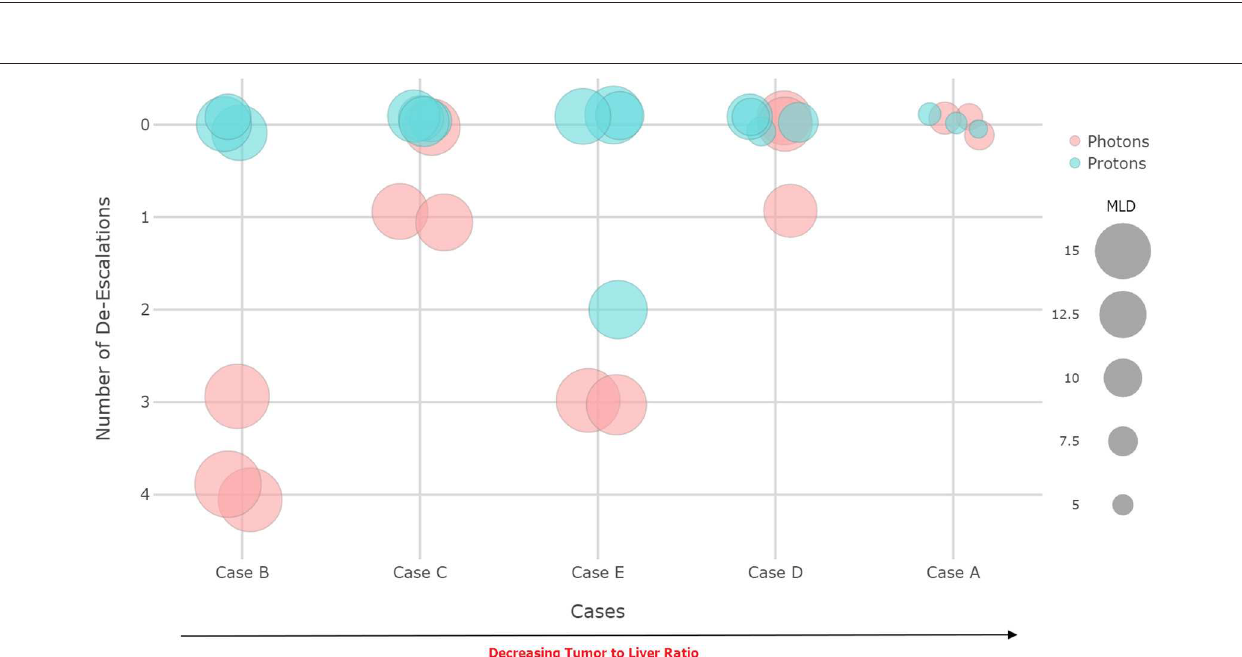
FIGURE 2 | Achieved prescription dose and mean liver dose (MLD) for x-ray vs. proton treatment